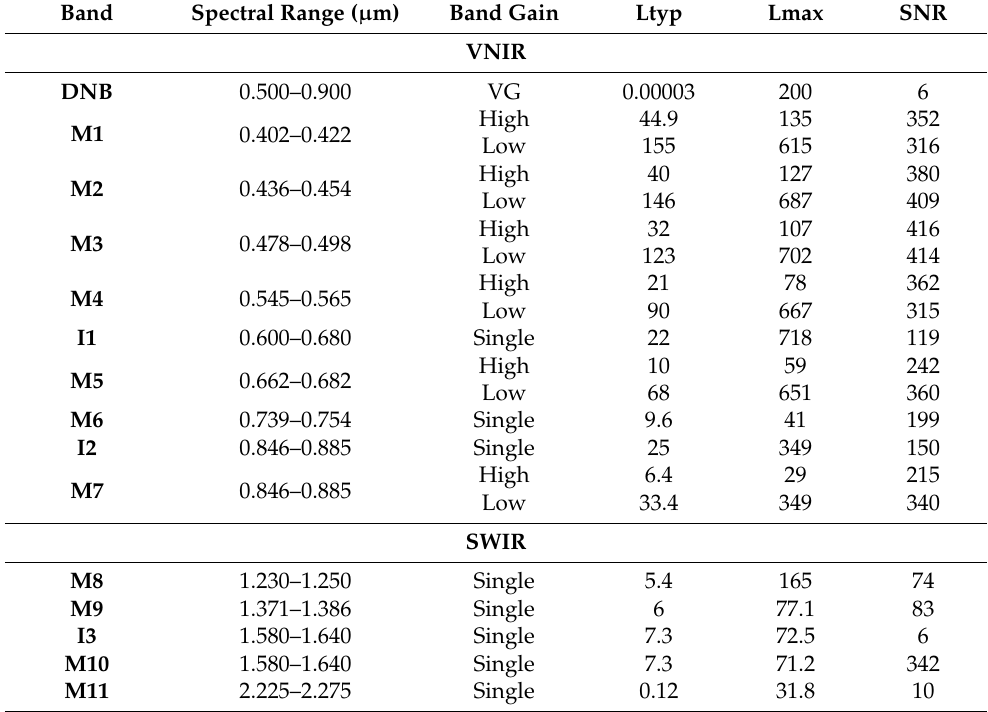
Table 1. VIIRS spectral, dynamic range, and noise requirements for the reflective solar bands.